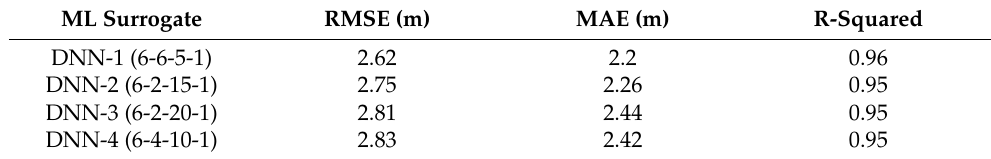
Table 2. The top performing DNNs with their architecture and corresponding error metrics.